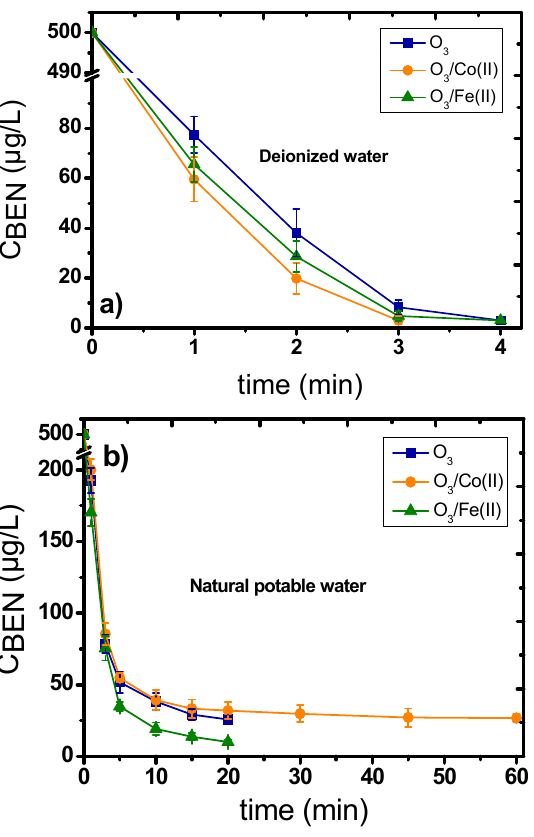
Figure 2. Catalytic ozonation of benzotriazole with the presence of Fe(II) and Co(II) as catalysts, using ( a ) deionized and ( b ) dechlorinated natural potable water. Experimental conditions: initial benzotriazole concentration 500 μ g/L, ozone concentration 2 mg/L, catalyst concentration 1 mg/L, pH 7.8, temperature 23 ± 2 °C.